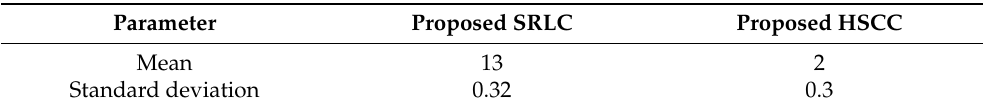
Table 6. Monte Carlo simulation